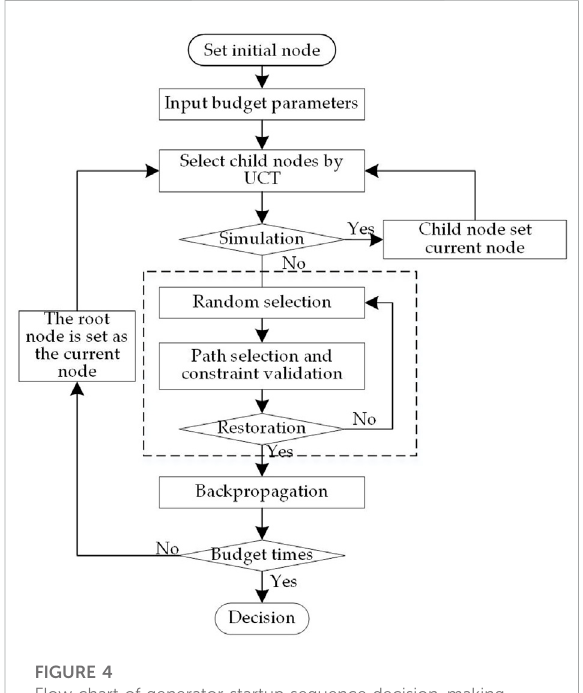
FIGURE 4 Flow chart of generator startup sequence decision-making.